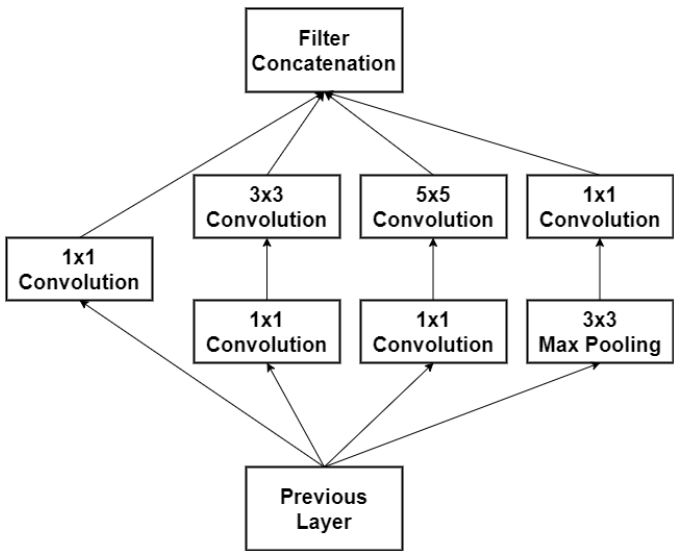
Figure 5. Inception module structure: parallel convolutions.